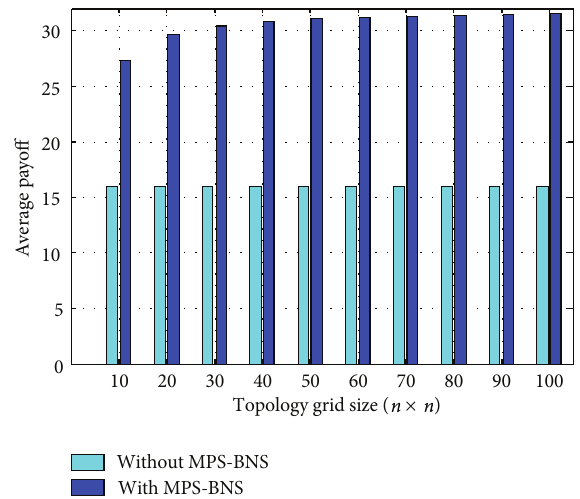
S 3: Average payoffs per player of evolution of MPS-BNS as pure